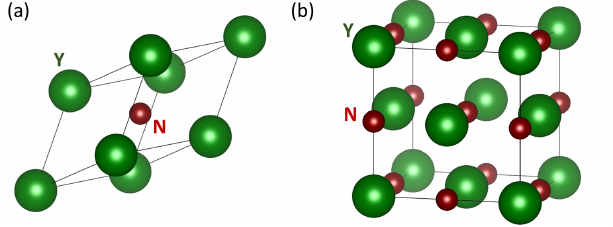
Figure 1. Schematic visualization of the 2-atom primitive ( a ) and 8-atom conventional cube-shape ( b ) unit cells of NaCl-structure of YN (some atoms are shown together with their periodic